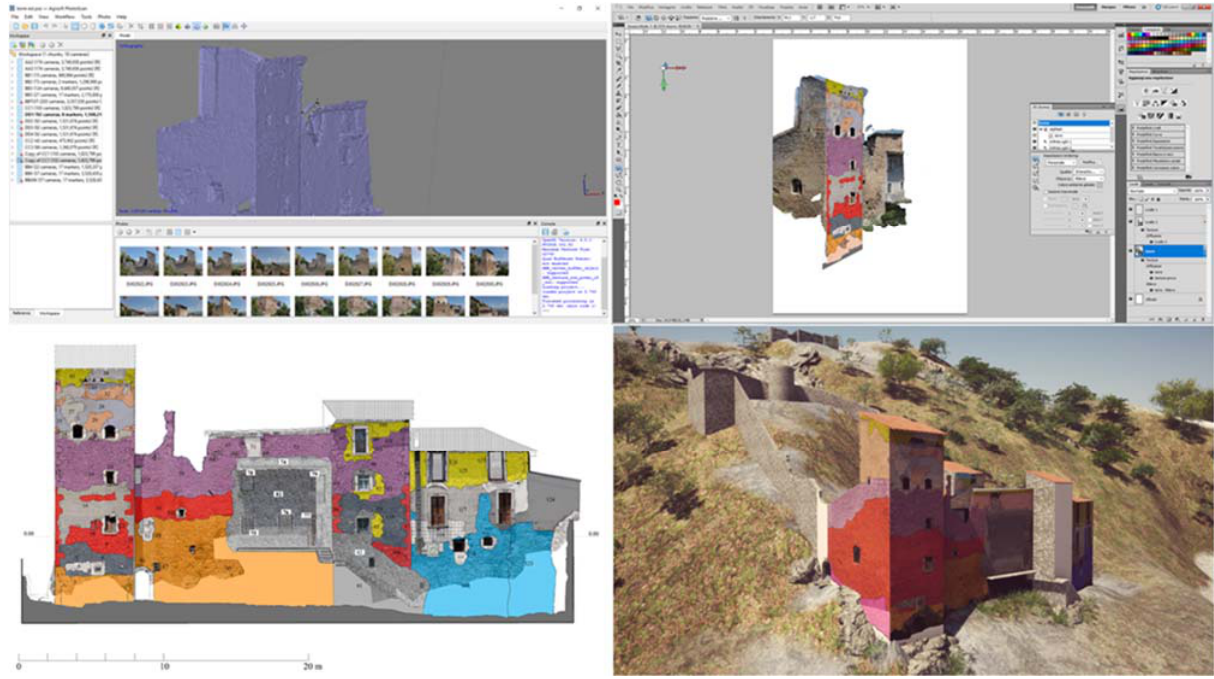
Figure 2: Stratigraphic analysis made on the three-dimensional model and on the front of the castle and the stratigraphic analysis imported into the virtual environment (this last made by A. Cordisco) 5. METHODOLOGY FOLLOWED: